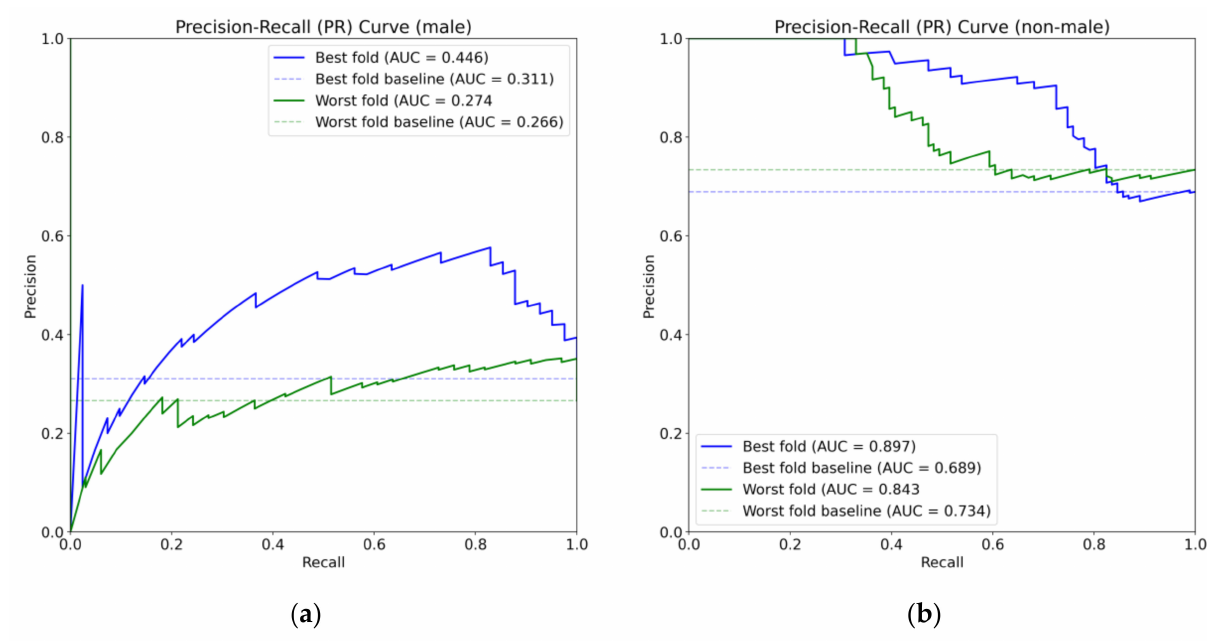
Figure 4. PR curve for predictions of the tracks. ( a ) PR curve where males are positive class. ( b ) PR curve where non-males are positive class.